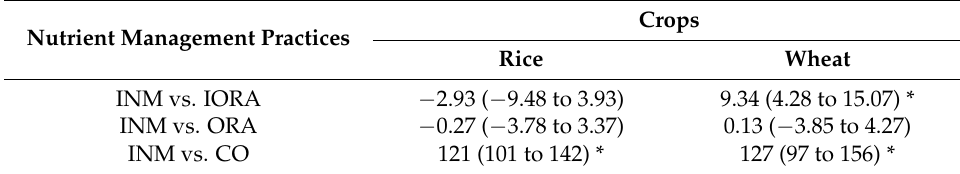
Table 1. Influence on net returns in rice and wheat with integrated nutrient management over inorganic alone, organic alone, and control treatments in